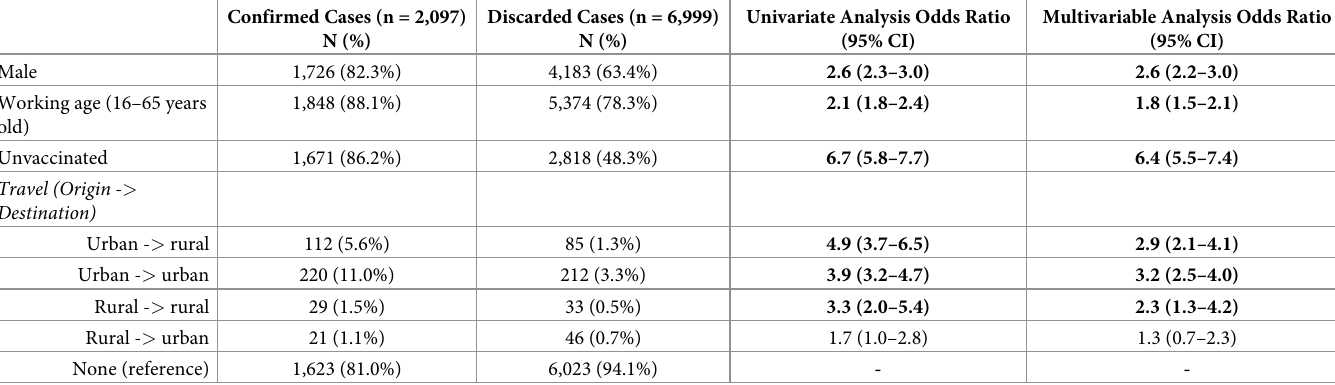
Table 1. Demographic characteristics of confirmed versus discarded YFV cases in 2017 &